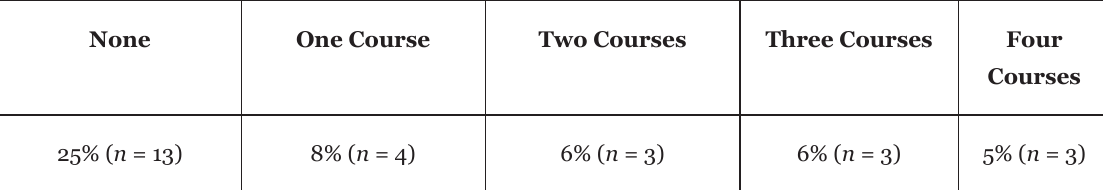
Responses to the Question about Teaching Fully Online Distance Education Courses